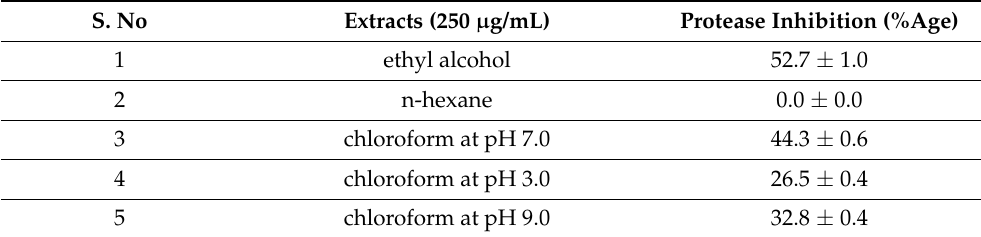
Table 3. Protease inhibition activity of the extracts of Camellia sinensis . S. No Extracts (250 µ g/mL) Protease Inhibition (%Age) 1 ethyl alcohol 52.7 ± 1.0 n-hexane chloroform at pH 7.0 chloroform at pH 3.0